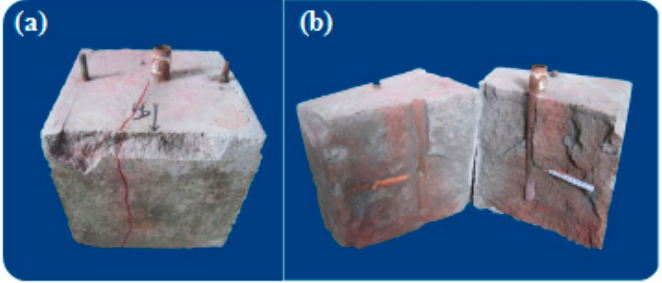
Figure 15. Fracture morphology after hydraulic fracturing of sample 1#: ( a ) the overall picture before opening; ( b ) the inner picture after opening.